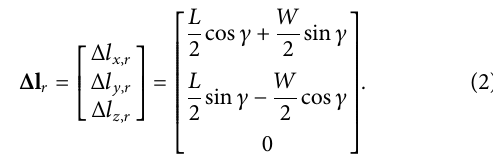
Frontiers in Robotics and AI |